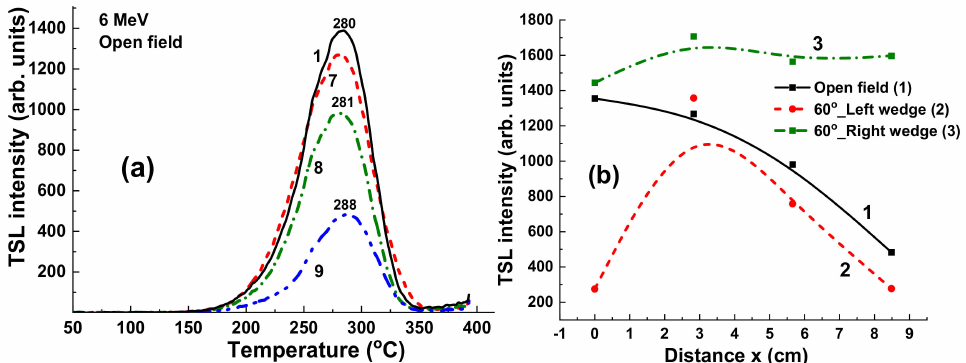
Figure 10. ( a ) TSL glow curves for YAG:Ce crystal samples irradiated by 6 MV X-ray photons from a Clinac 2300 accelerator in open field mode; ( b ) dependence of intensity of TSL peaks on the distance x between sample and centers of target (see Figure 1).